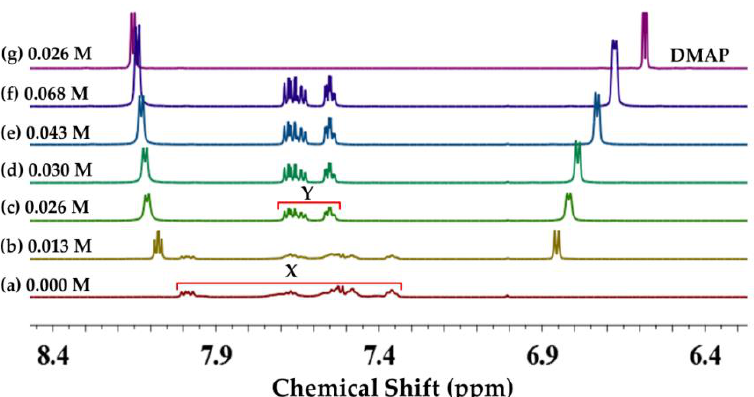
Figure 5. 1 H NMR spectra illustrating the changes observed in the substitution of triphenylphosphine oxide from cis -[NbO(ca) 2 (H 2 O)OPPh 3 ] − (0.013 M) ( a ), by DMAP (0.013 – 0.068 M) ( b – f ) at 25 °C in CD 3 CN. X represents coordinated OPPh 3 in the starting complex ( a ) (0.013 M), while Y gives the stepwise liberated OPPh 3 upon addition of an excess of DMAP ( f ) (0.068 M), respectively. Spectrum ( g ) was obtained using pure DMAP.